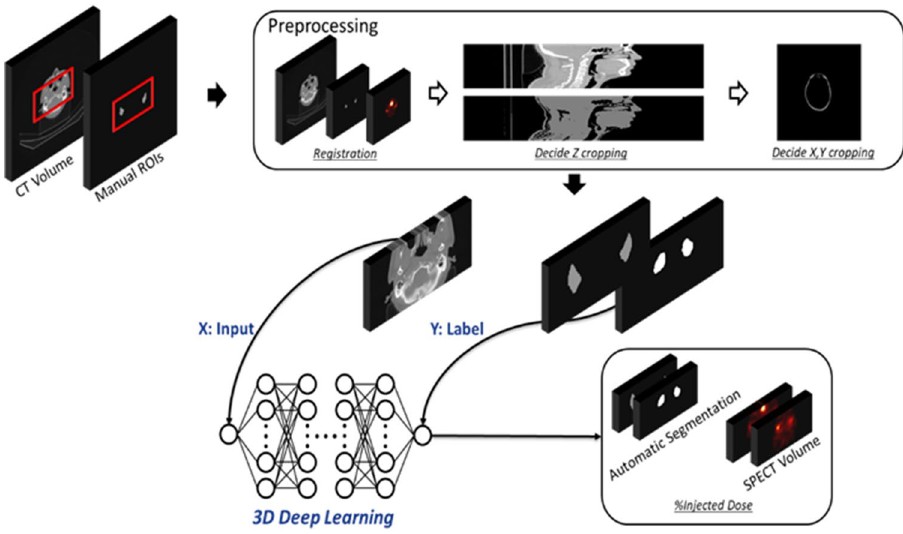
Figure 5. Schematic diagrams of the deep-learning-based salivary gland segmentation for %ID measurement using quantitative